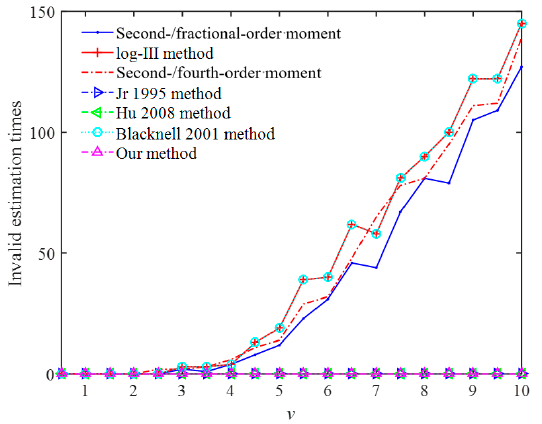
Figure 1. The relationship between v and invalid estimation times in the data of the simulated K- distribution.